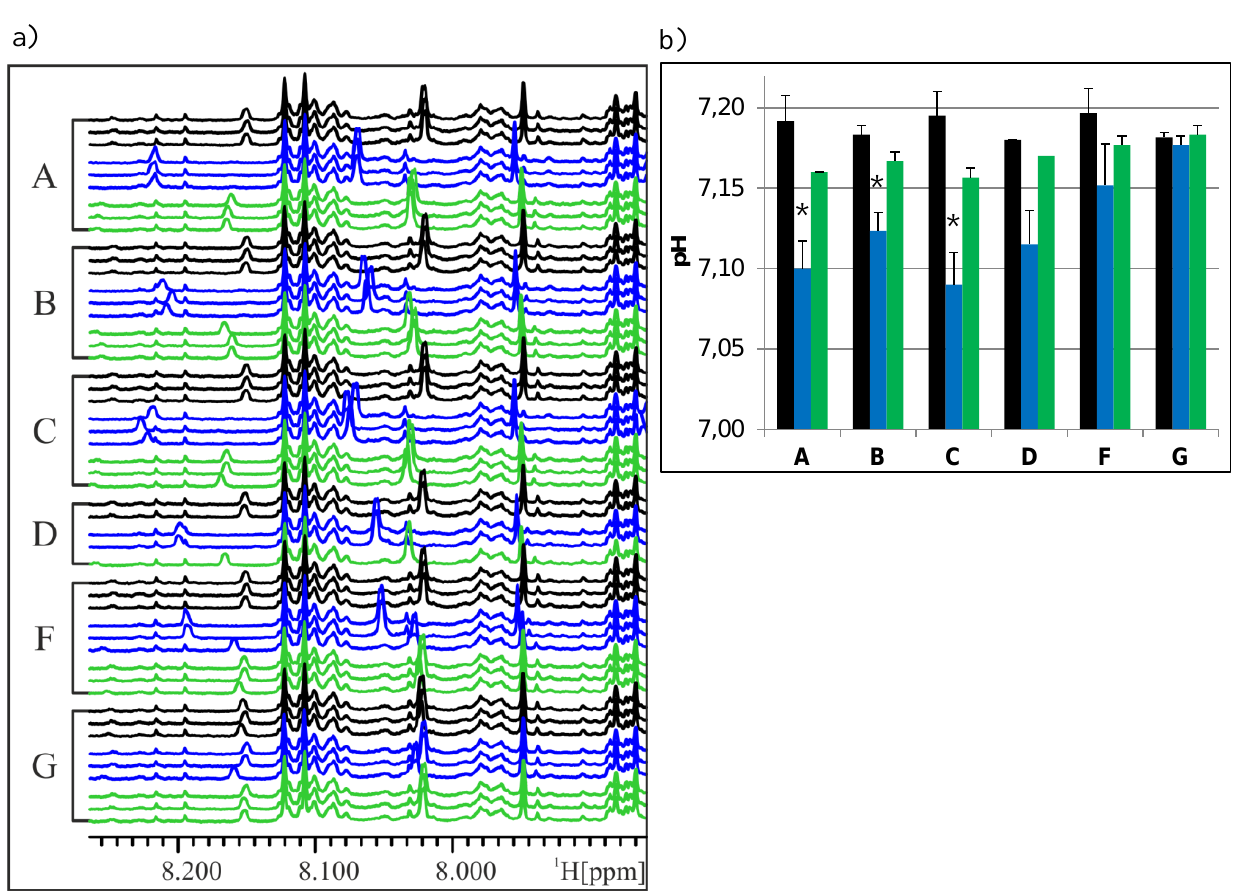
Figure 6. Influence of storage vial on NMR spectra and pH of urine samples frozen under different conditions. ( a ) Variable region of NMR spectra of urine samples frozen at different temperatures and in different PP cryo or glass vials, colored according to freezing condition. Black: −20 °C; blue: dry ice; green: −80 °C. ( b ) pH values of corresponding urine samples, colored according to freezing temperature (see above). N = 3, except D (n = 1–2), values given as the mean + SD. * p < 0.05 vs. all other samples of the same vial (two-way ANOVA) (there are no statistics for D, due to a low number of